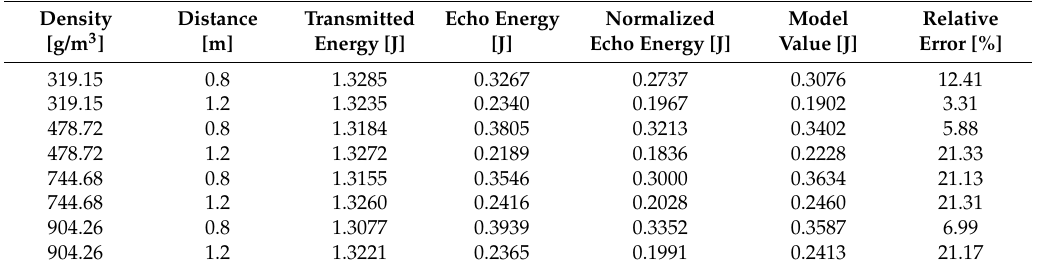
Table 11. Canopy density model universal analysis with 3 layers of leaves.